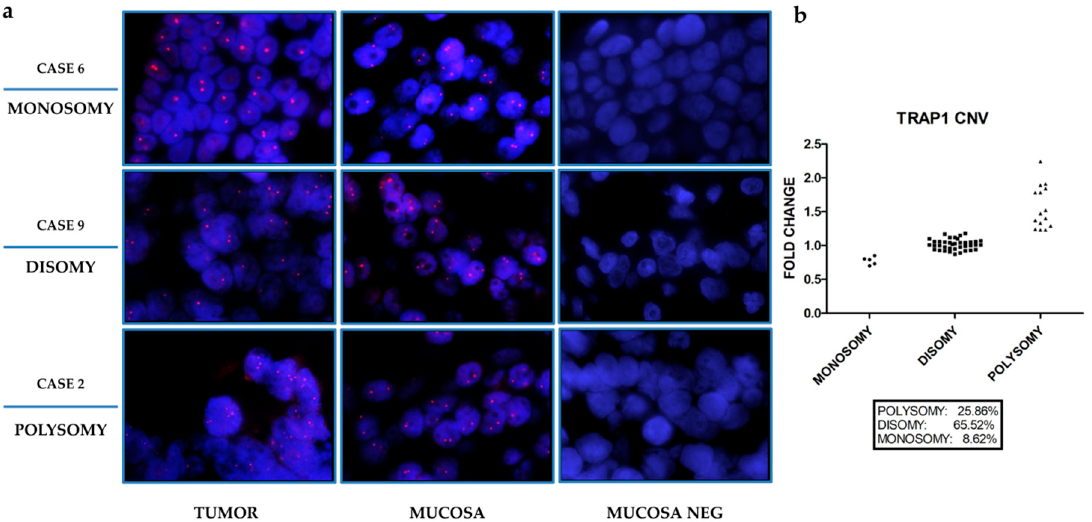
Figure 1. Tumor Necrosis Factor Receptor-Associated Protein 1 (TRAP1) copy number variation in human colorectal carcinomas. ( a ) Fluorescent in situ hybridization (FISH) assessment of TRAP1 copy number variation in three representative cases of human colorectal carcinoma and the corresponding non-infiltrated mucosa (magnification, 100 × ). Positive signals of hybridizations are shown in red, nuclei are counterstained with DAPI (Blue). Mucosa lacking TRAP1 probe (MUCOSA NEG) is reported as a negative control. ( b ) Frequency of TRAP1 copy number variation evaluated by RT-PCR in 58 human colorectal carcinomas. Table 2. Comparative fluorescent in situ hybridization (FISH) and RT-PCR analysis of TRAP1 gene CN.